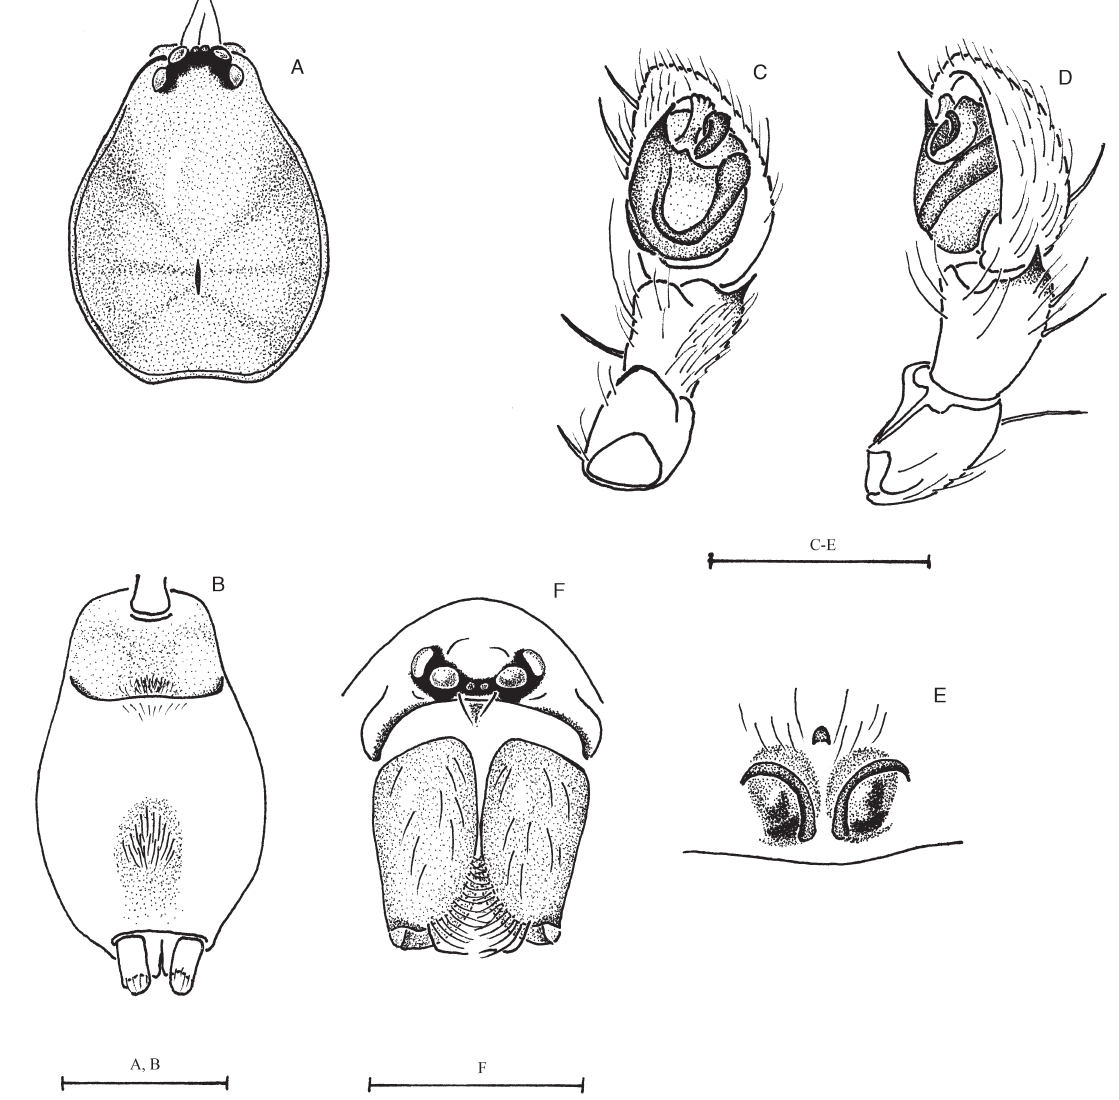
Fig. 10. Cteniogaster hexomma sp. nov. A. ♂, habitus, dorsal view. B. Idem, abdomen, ventral view. C. Idem , palp, ventral view. D. Idem, retrolateral view. E. Epigyne, ventral view. F. ♀, carapace, anterior view. Scale bars: A-B, F = 0.5 mm, C-E = 0.25